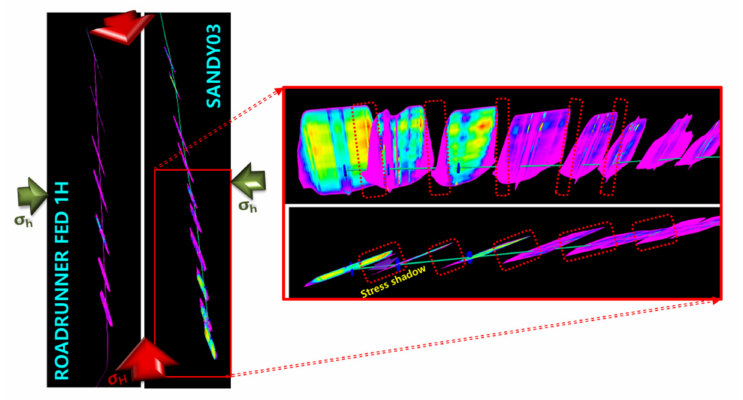
Figure 9. HFT results of horizontal wells drilled toward σ Hmax